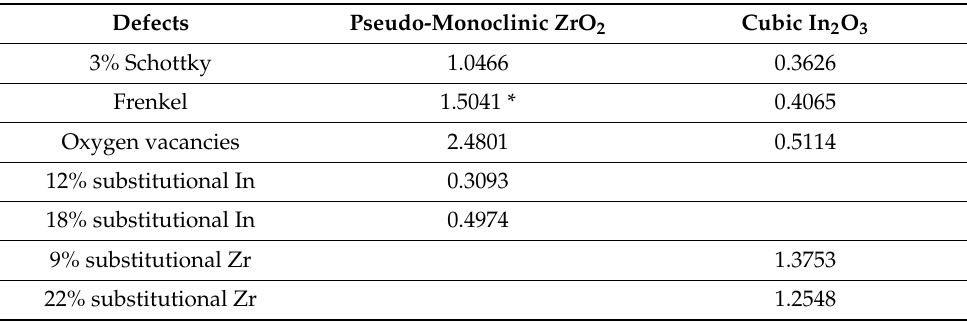
Table 6. Oxygen diffusion activation energy (eV) in defective crystals. * Indicates that not all temperatures were used due to negative diffusivity being calculated in one of